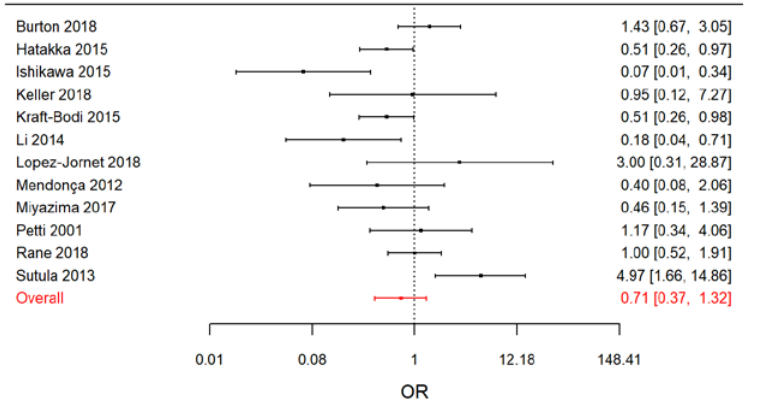
Figure 4. Forest plot from the Bayesian random-effects meta-analysis on all the selected studies.